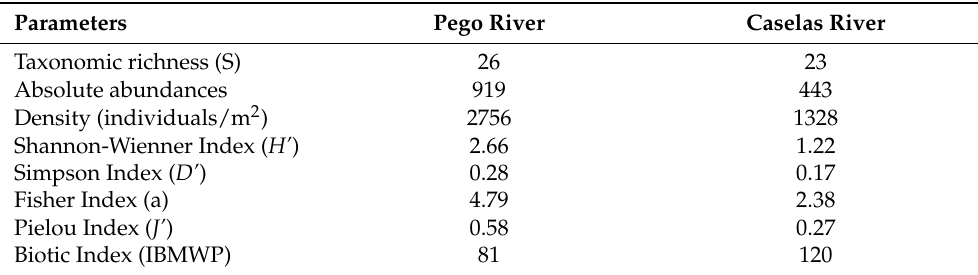
Table 2. Values of the descriptive parameters of the macroinvertebrate communities in both rivers. Taxonomic richness (Families), absolute abundance, density (ind/m 2 ) and values of Shannon-Wiener, Simpson, Fisher, Pielou, and IBMWP indexes.